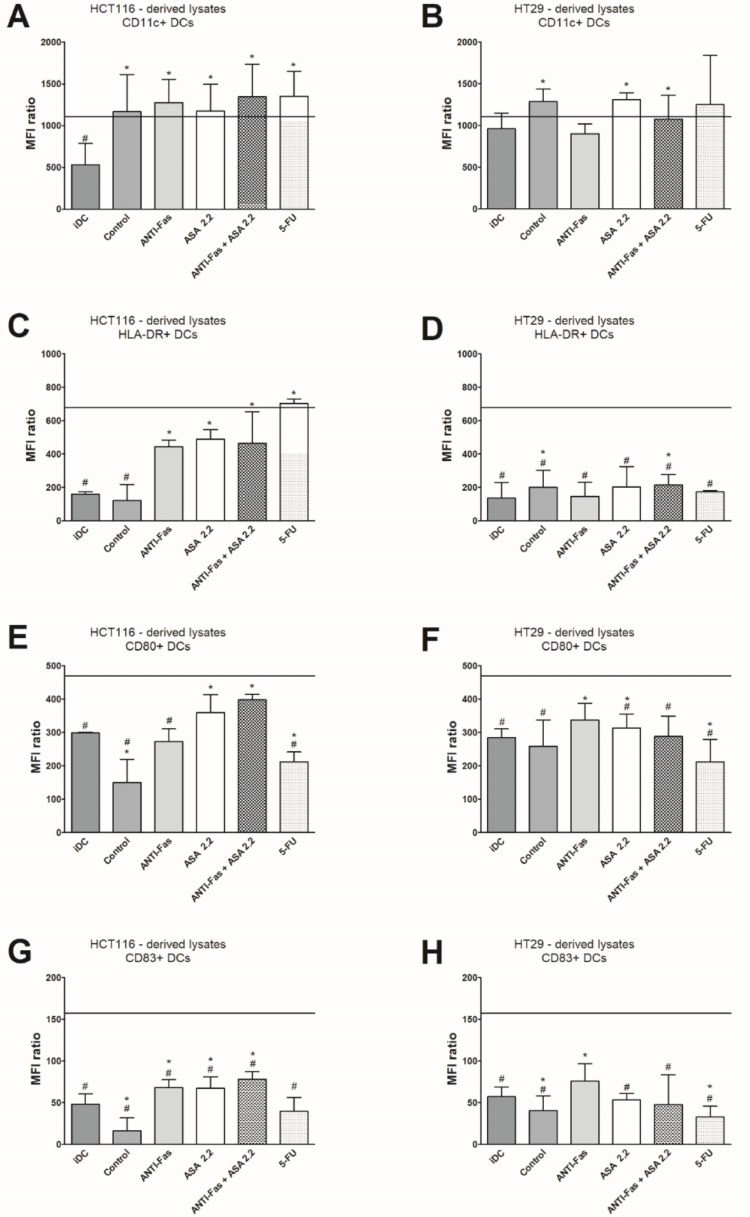
Figure 7. The effect of cancer cell lysates or LPS on the proportions of CD11c+ ( A , B ), HLA-DR+ ( C , D ), CD80+ ( E , F ) and CD83+ ( G , H ) DCs. Data are presented as mean fluorescence intensity (MFI) related to unstained control. Lysates used in these analyses were collected from cultures of HCT116 and HT29 CRC cell lines expanded for 10 days in spherical forms with agonistic anti-Fas antibody (200 ng/mL) and/or aspirin (ASA) (2.2 mM or 1.8 mM for HCT116 or HT29, respectively), or 5-FU (50 µ M). The value of LPS–timulated DCs was set on Y-axis with continuous line. DCs incubated with lysates prepared from cancer cells not treated are defined as CONTROL in the Figure. Bars and whiskers represent median ± interquartile range. Statistically significant differences assessed by Kruskal-Wallis test were followed by Dunn’s test as a post hoc procedure or U Mann-Whitney test. (* p < 0.05 vs iDCs, # p < 0.05 vs LPS). Three independent experiments were performed.